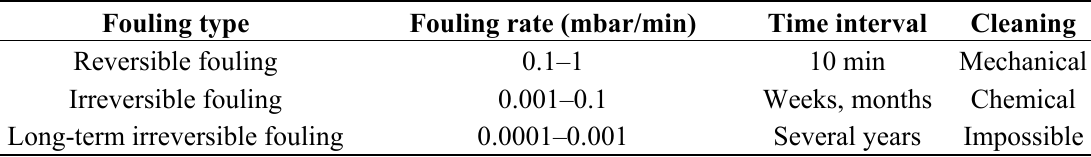
Table 3. Types of fouling. Adapted from Kraume et al . [3] in Geilvoet